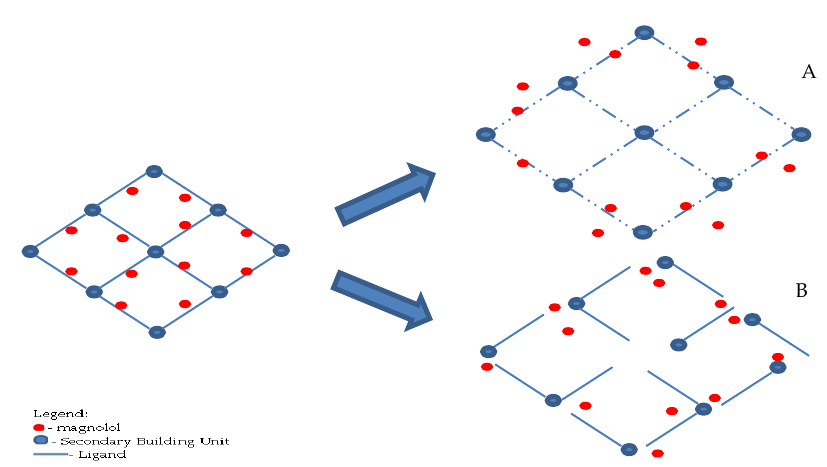
Figure 10. Illustration of the release of magnolol from mag@Uio-66(Zr) depicting ( A ) swelling and diffusion and ( B ) tension and breaking.